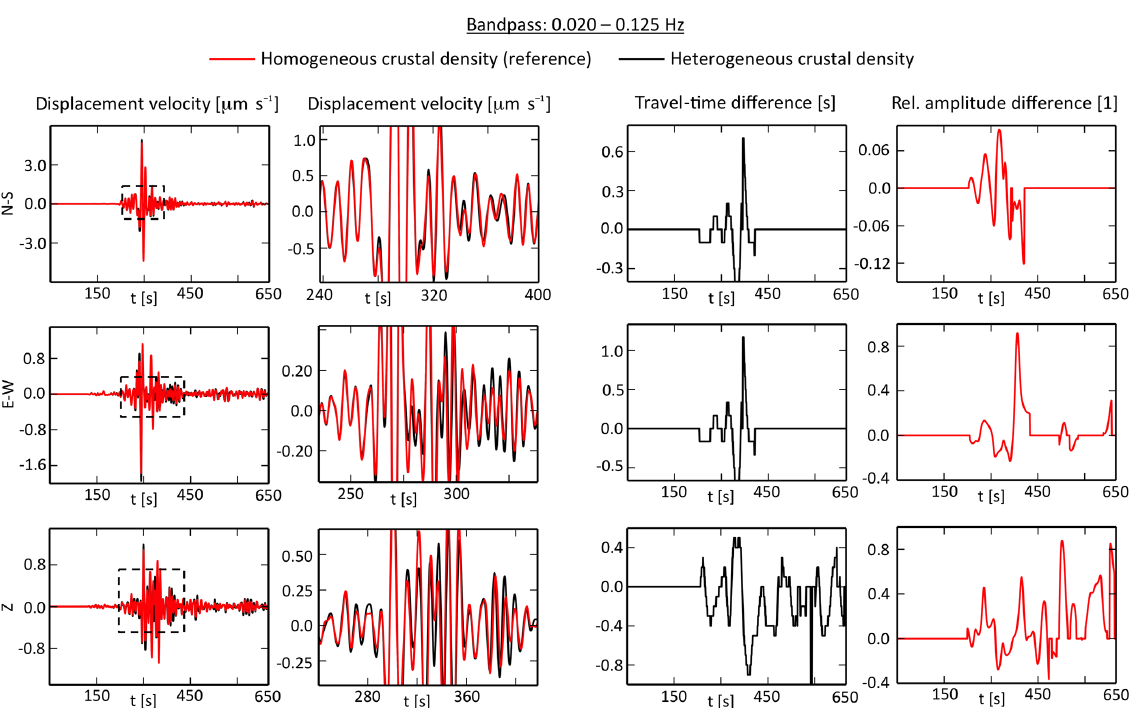
Figure 3. Comparison of synthetic seismograms for homogeneous and heterogeneous crustal densities in the broadest frequency band from 0 . 020 to 0 . 125Hz (8–50s). The receiver is located at an intermediate epicentral distance of 910km, and is marked by a red triangle in Fig. 1. The correlation lengths of the heterogeneities in velocities and density are 200km in the horizontal and 20km in the vertical directions. The first column displays the seismograms on the N–S, E–W and Z components for the reference medium with homogeneous crustal density (red) and a medium with random heterogeneous crustal density (black). For better visibility, a zoom into the interval indicated by the black-dashed box is shown in the second column. The third and fourth columns display the time-dependent travel time and relative amplitude difference of the two sets of seismograms shown to the left. Extreme travel-time differences due to cycle skips are cropped to enhance visibility of physically meaningful travel-time